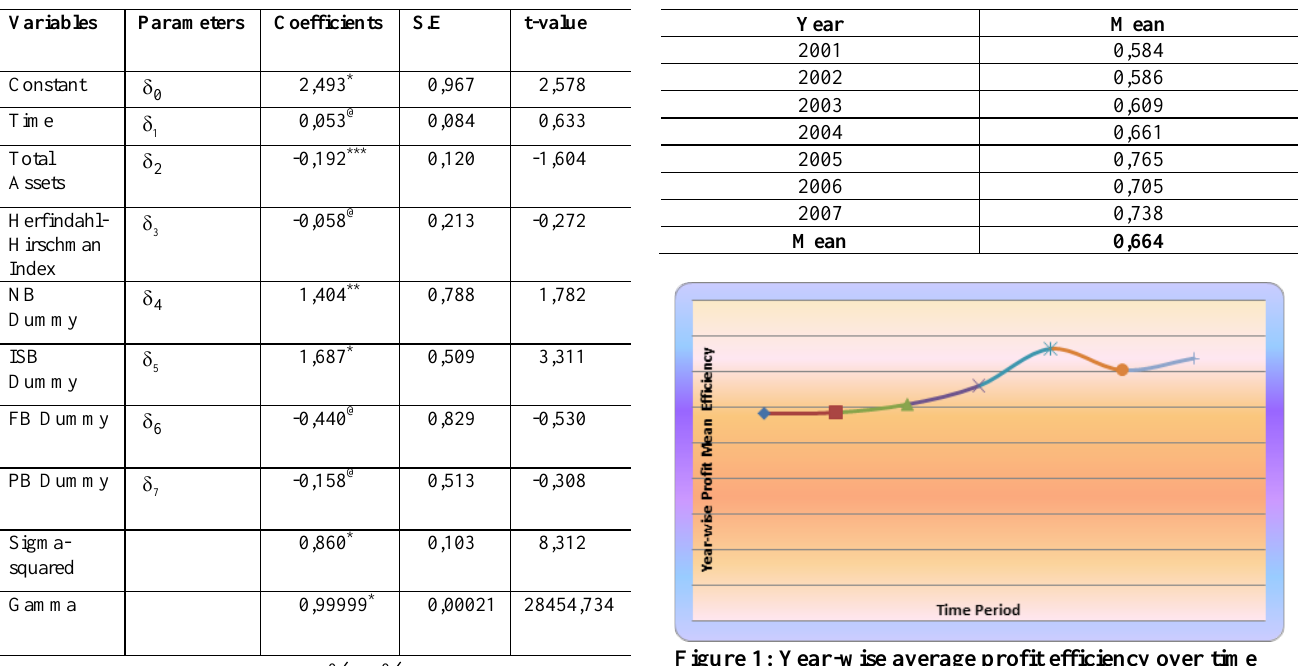
Table 5: Yea-wise average profit efficiency of banks in